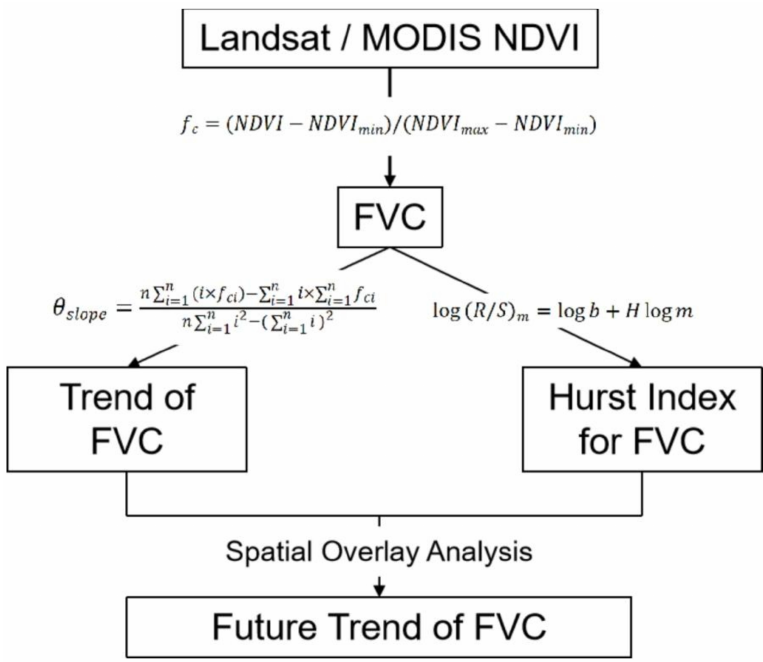
Figure 2. The Flowchart of methodology.